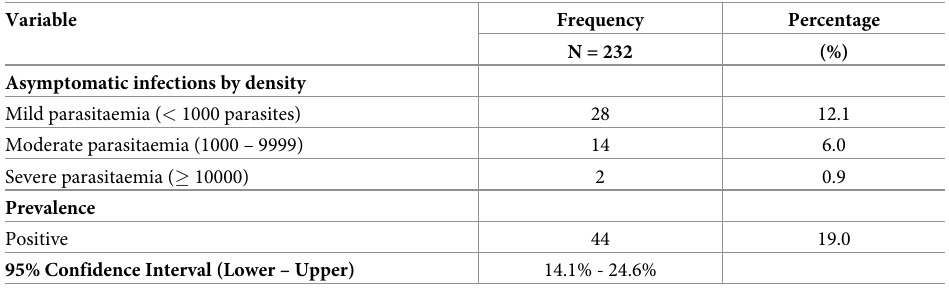
Table 2. Prevalence and parasite density of asymptomatic infections by Microscopy (N =